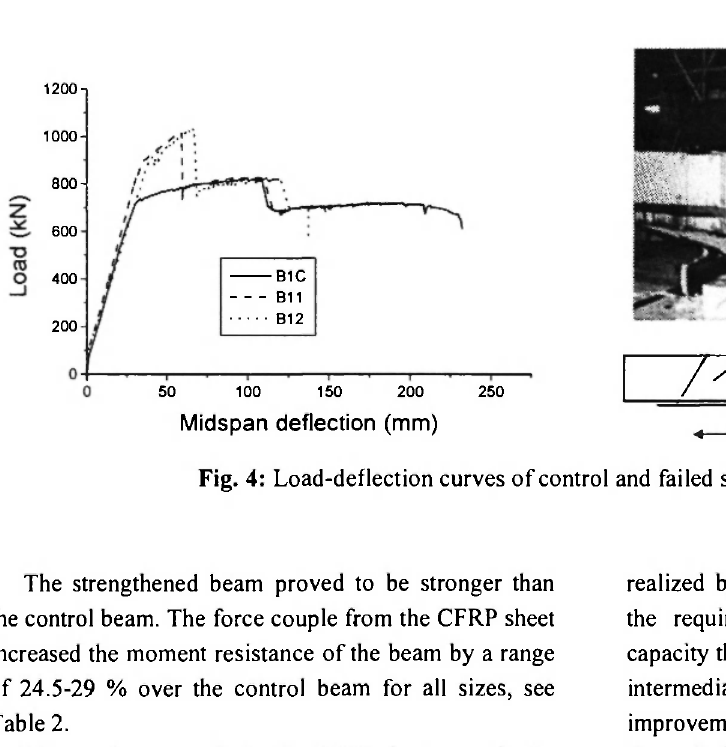
Fig. 4: Load-deflection curves of